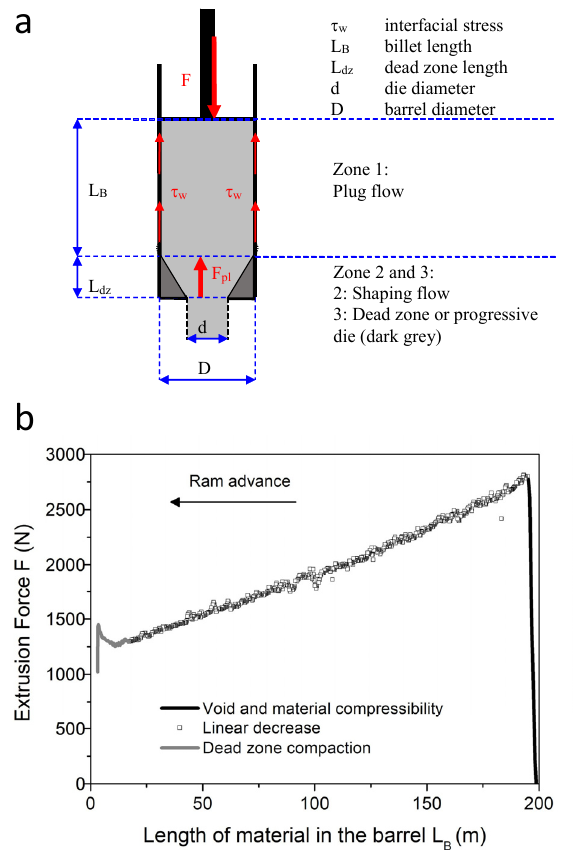
Figure 3. a) Schematic view of an axisymmetric ram extrusion flow and b) evolution of extrusion force F with length of material remaining in the plug flow zone.